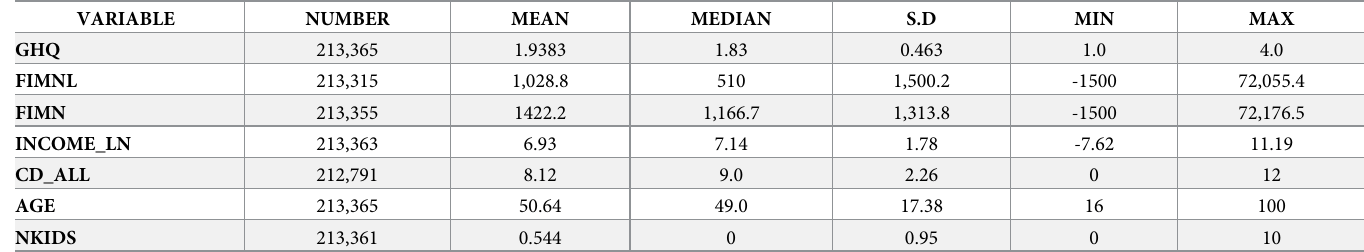
Table 1. Descriptive statistics of quantitative variables.